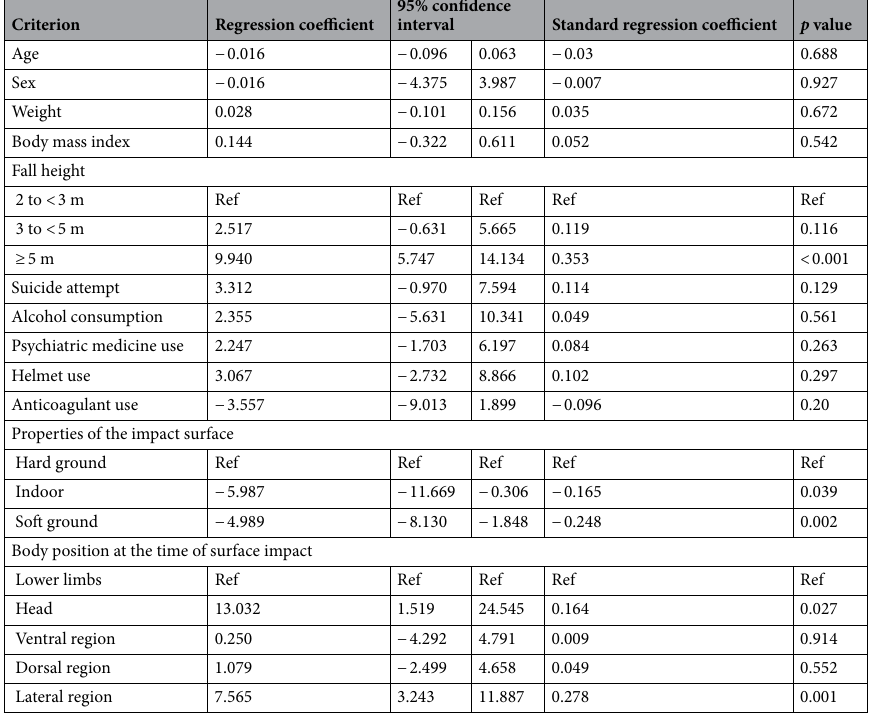
Table 2. Univariate regression analysis results for the injury severity score.